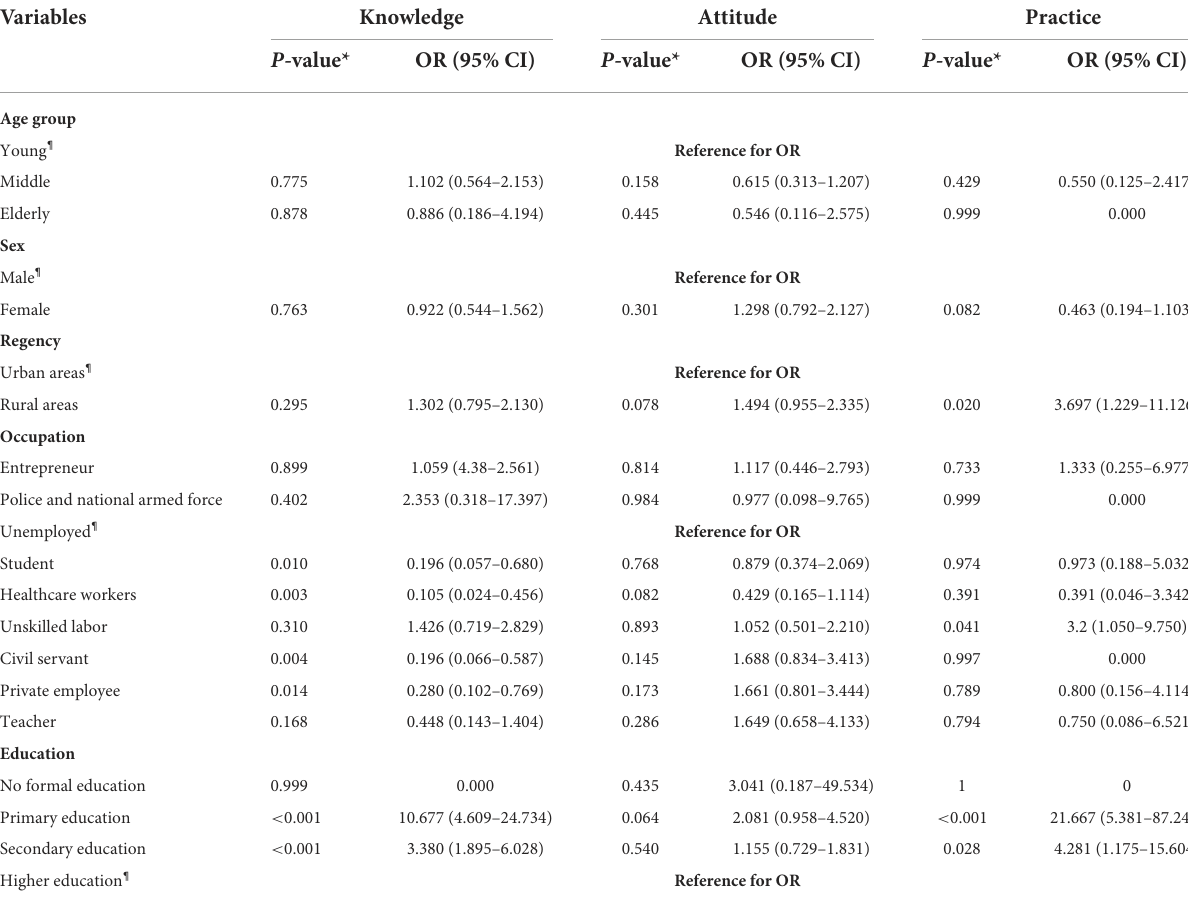
TABLE 6 Odds ratio and 95% confidence interval (CI) for odds ratio of the logistic regression for poor knowledge, poor attitude and poor practice ( n =